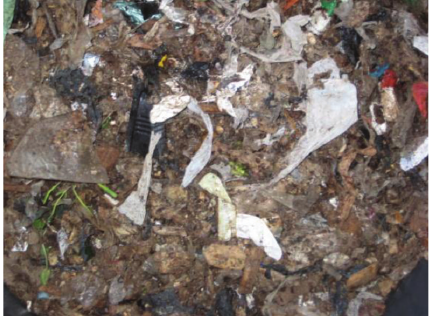
Figure 1: MBT output sample.